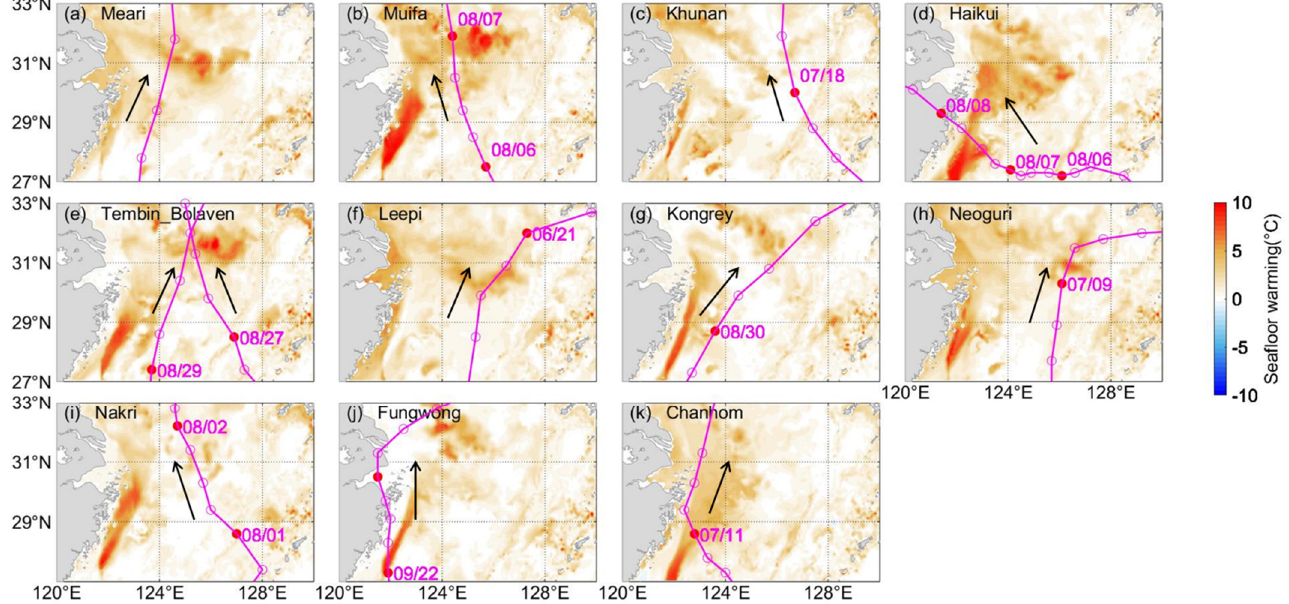
Figure 8. Seafloor warming of Zhejiang coastal waters caused by the 12 typhoons: ( a ) Meari, ( b ) Muifa, ( c ) Khunan, ( d ) Haikui, ( e ) Tembin_Bolave, ( f ) Leepi, ( g ) Kongrey,( h ) Neoguri, ( i ) Nakri, ( j ) Fungwong and ( k ) Chanhom. The black arrow(s) in each subfigure denotes the moving direction of the typhoon(s).